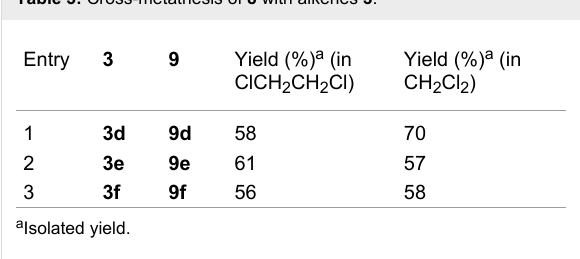
Table 3: Cross-metathesis of 8 with alkenes 3